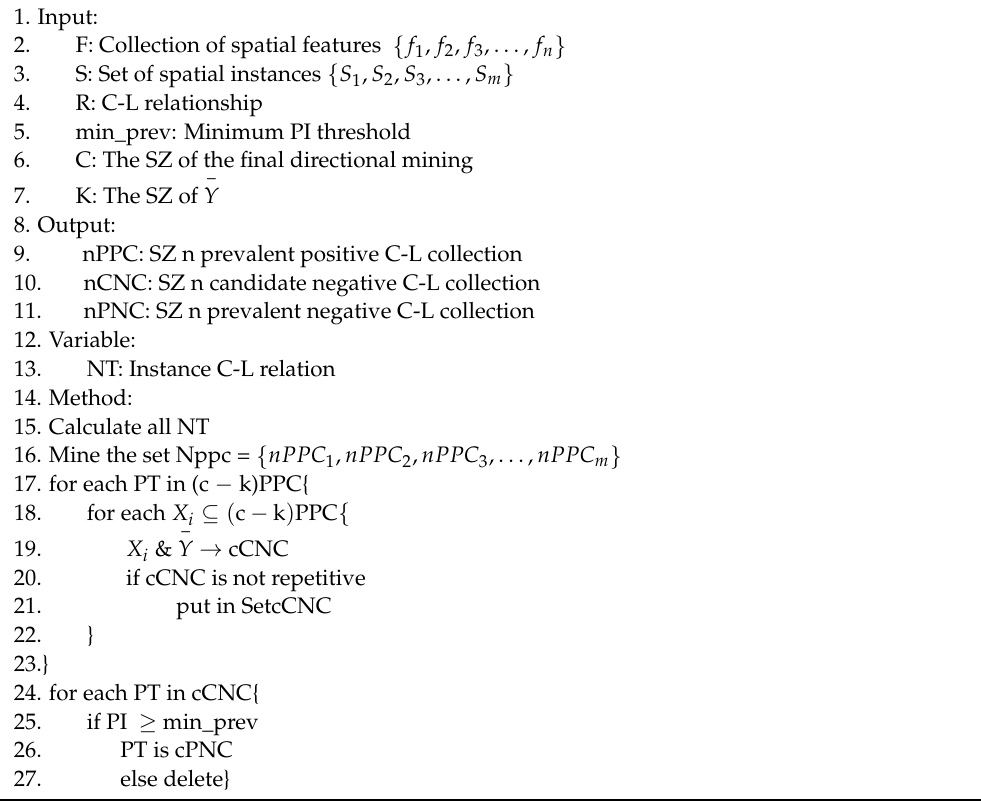
Algorithm 2: Join-based prevalent negative co-location pattern directional algorithm.